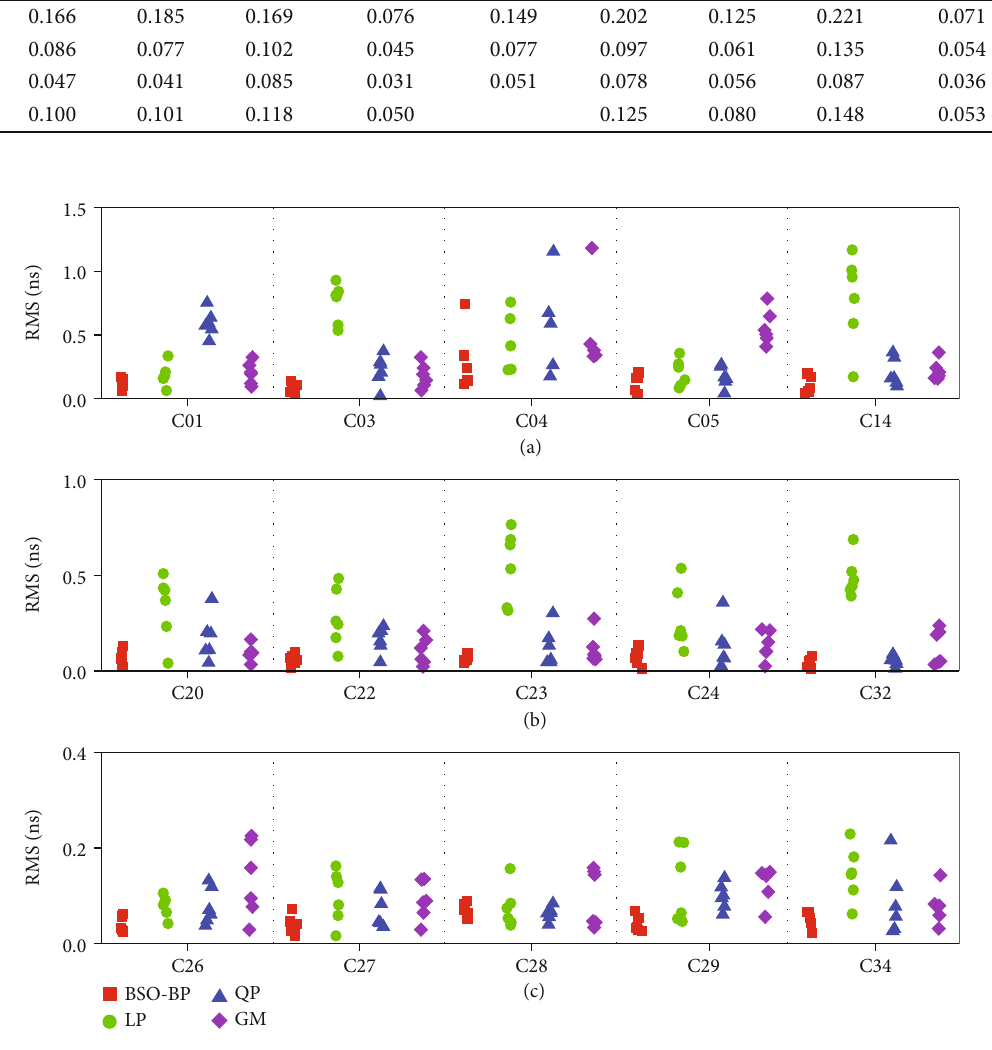
Figure 14: The prediction accuracy of 6 days for 1 hour using 6-hour SCB data: (a) residual distribution of fi ve Rb clocks; (b) residual distribution of fi ve Rb-II clocks; (c) residual distribution of fi ve PHM